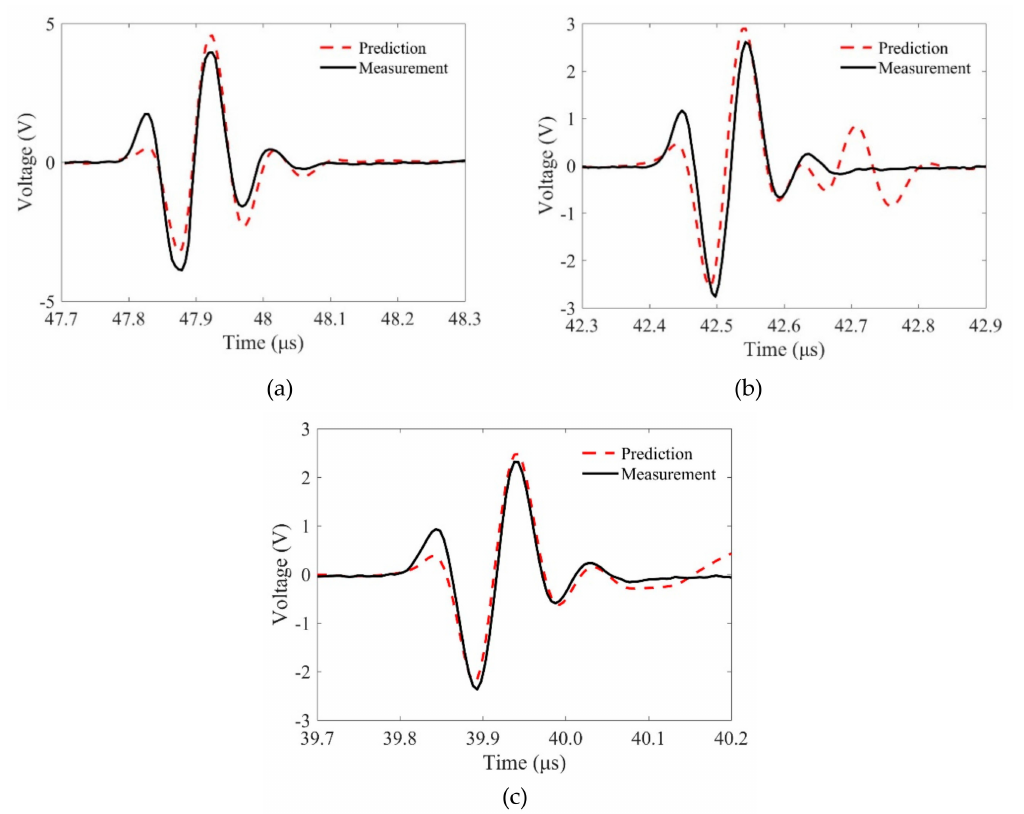
Figure 10. Comparisons of the flaw signals between predictions and measurements at normal incidence, θ = 0 ◦ when the radii of curvature are ( a ) R = ∞ , ( b ) R = 50 mm, and ( c ) R = 30 p 1